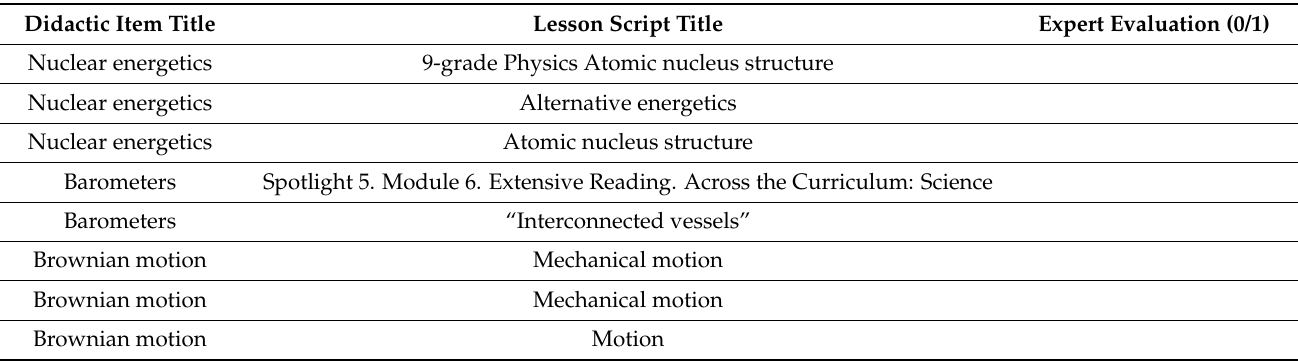
Table 3. Example of data mapping representation for expert evaluation.